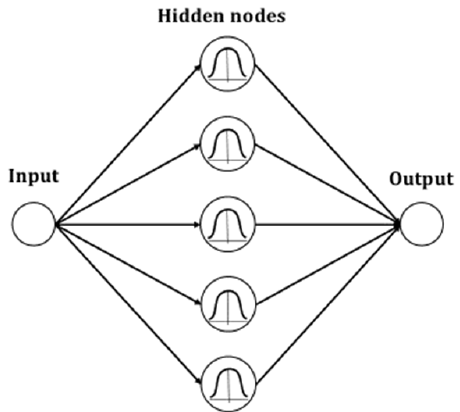
Figure 3. Structural diagram of the radial basis function with one hidden layer.